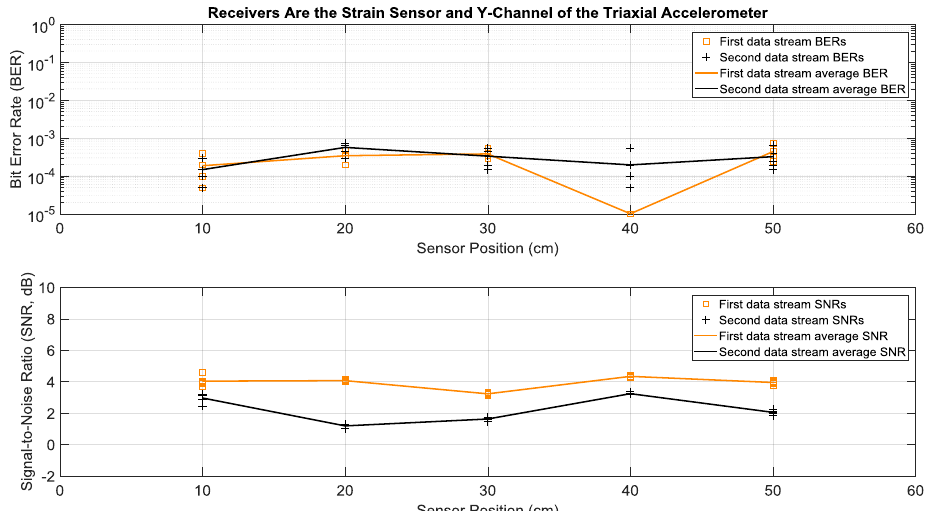
Figure 7. BERs ( top ) and SNRs ( bottom ) at different receiver positions, with two actuators transmitting two data streams simultaneously. The receivers were a strain sensor and the y -channel of a triaxial accelerometer. The piecewise linear graphs represent average BERs and SNRs for each of the two data streams versus the receiver position.